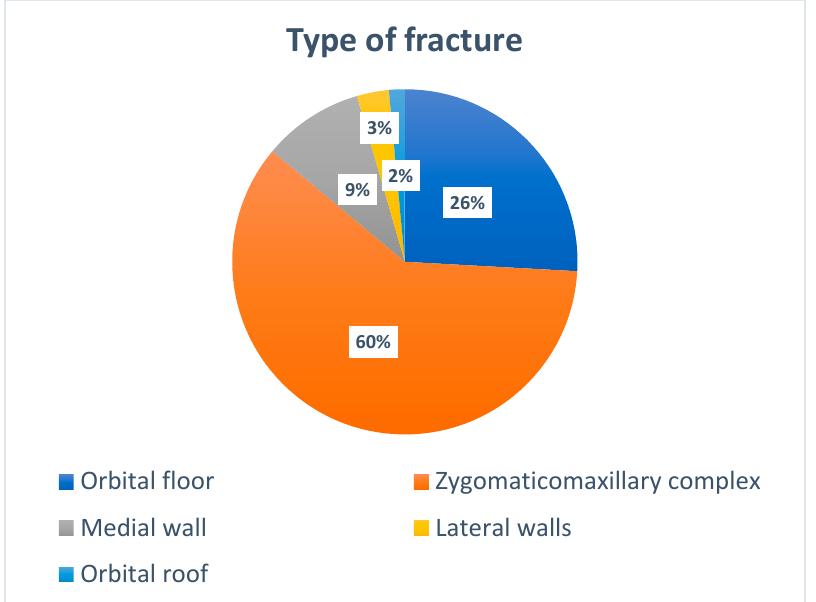
Figure 2. Type of fracture.